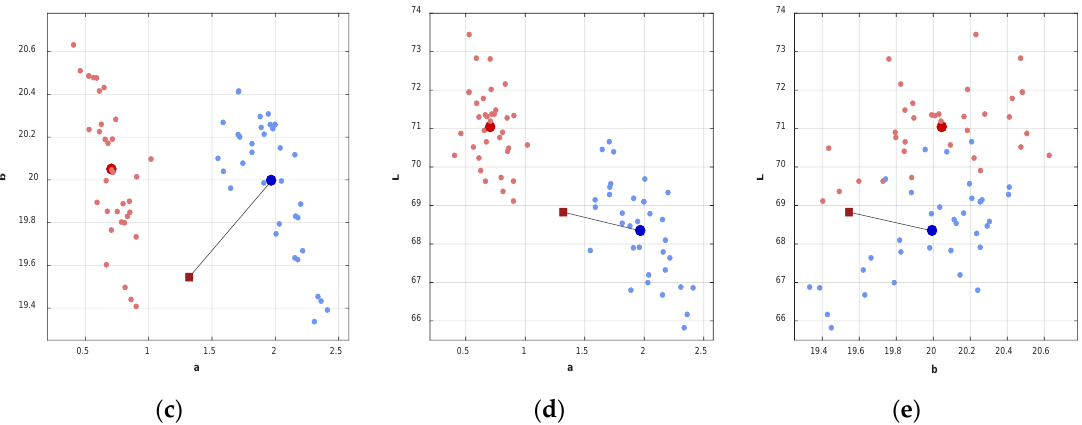
Figure 7. Colors 3L2.5 and 3R2.5 of the 3D shade tab measured by the developed digital shade-matching device in the CIEL*a*b* color space: ( a ) two-dimensional hyperplane; ( b ) Euclidean distance in the three-dimensional color space; ( c – e ) Euclidean distance in the two-dimensional color space of the a*b*, L*a*, and L*b* axis. (Small red and blue circles: mean colors of 3L2.5 and 3R2.5 in the database; large red and blue circles: averaged color of the mean color group in the database; red square: mean color of 3L2.5 measured additionally for testing).